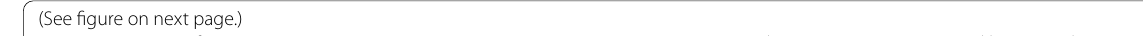
(See figure on next page.) Fig. 5 Expression of circ_0080145, circ 0051886, miR‑203, miR‑637, ABL1 mRNA/protein and BCR/ABL1 were compared between the